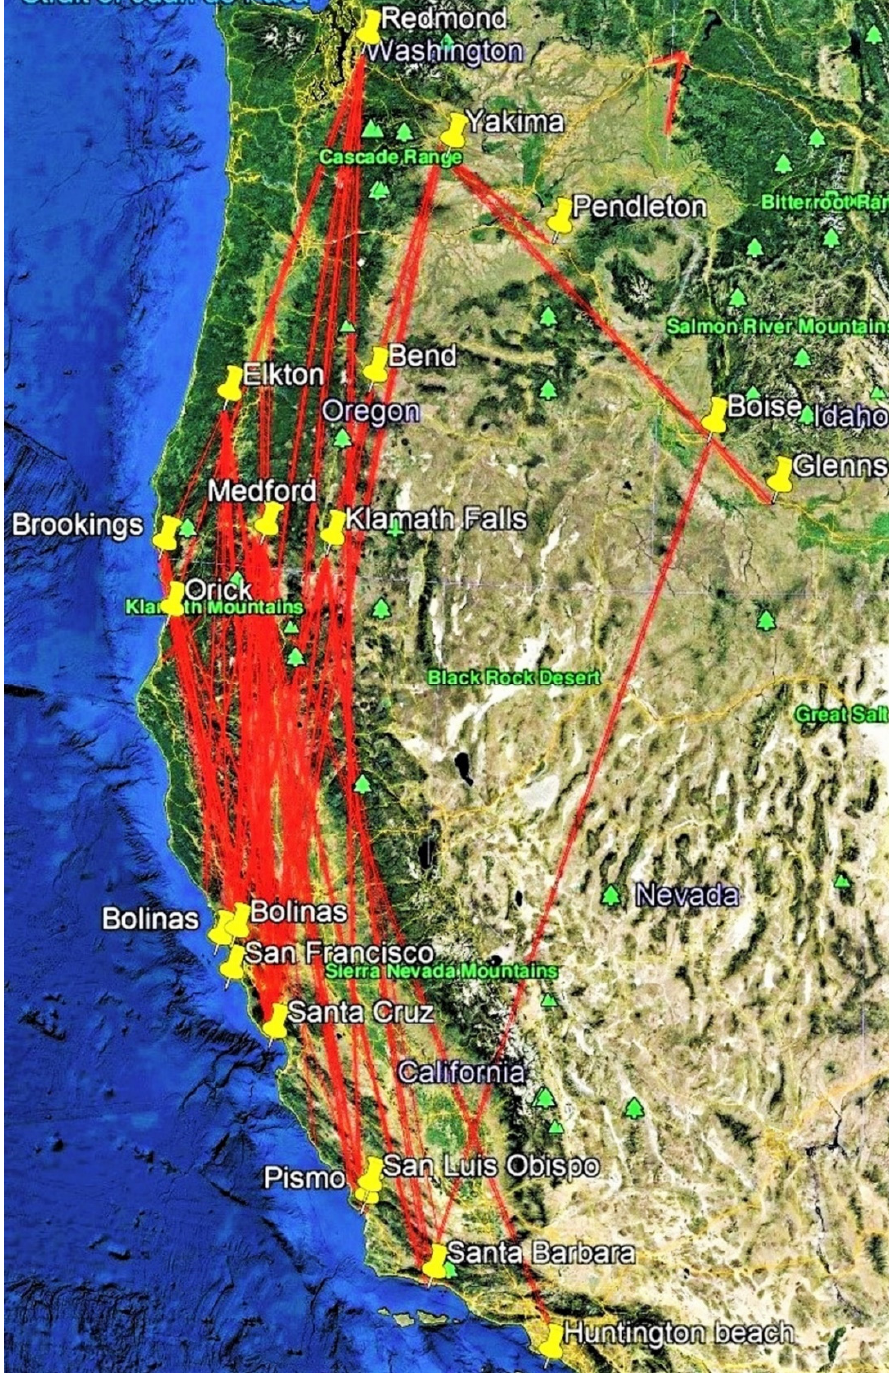
Figure 1. Release–recovery lines (from N to S) for captive-reared tagged monarchs released in the Pacific Northwest during 2017–2019.